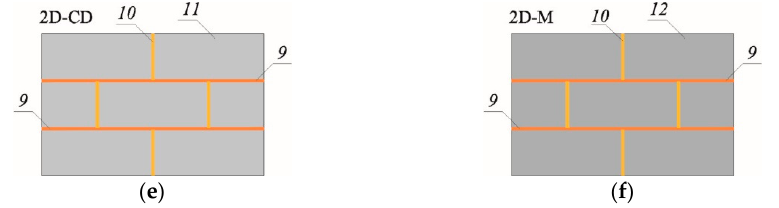
Figure 1. Adaptation of various strategies for building the wall micro-model with thin-wall joints without filled head joints: ( a ) actual structure of the modelled wall, ( b ) spatial wall micro-model (3D-F), ( c ) plane wall micro-model (2D-C), ( d ) plan wall micro-model (2D-D), ( e ) plan wall micro-model (2D-CD), ( e ) plane wall micro-model (2D-M); ( f ) plane wall micro-model (2D-M); 1—masonry element, 2—masonry mortar, 3—masonry element with linear or nonlinear parameters, 4—masonry mortar with linear or nonlinear parameters, 5—contact element of bed and head joints with nonlinear parameters, 6—masonry element with linear or nonlinear parameters, 7—mortar with linear or nonlinear parameters, 8—masonry element with linear parameters, 9—contact element of bed joints with nonlinear parameters, 10—contact element of head joints with nonlinear parameters, 11—masonry element with nonlinear parameters, 12—masonry element with equivalent nonlinear masonry parameters.